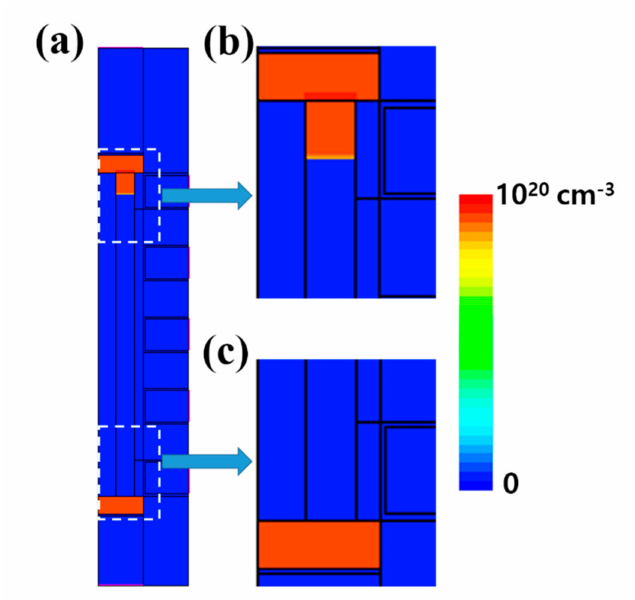
Figure 5. Doping concentration. ( a ) shows the entire structure, ( b ) shows the expanded DSL area, and ( c ) shows the expanded SSL area.